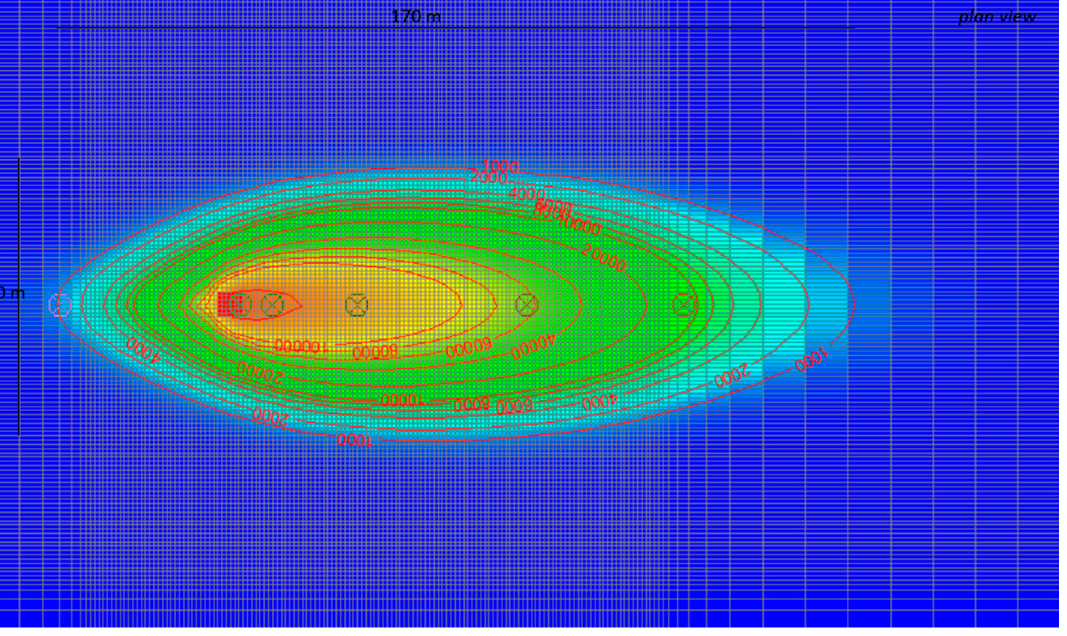
Figure 8. Contamination source zone (red square) and polluted area size of model A, after the simulation of the loading period (5 years).